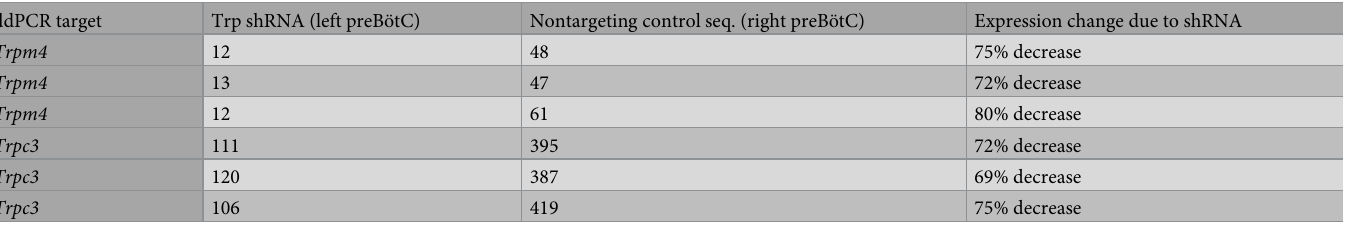
Table 1. Quantification of transcript copies of Trp genes per 2.5 ng cDNA synthesized from RNA extracted from the preBo¨tC of adult mice and measured by ddPCR. ddPCR